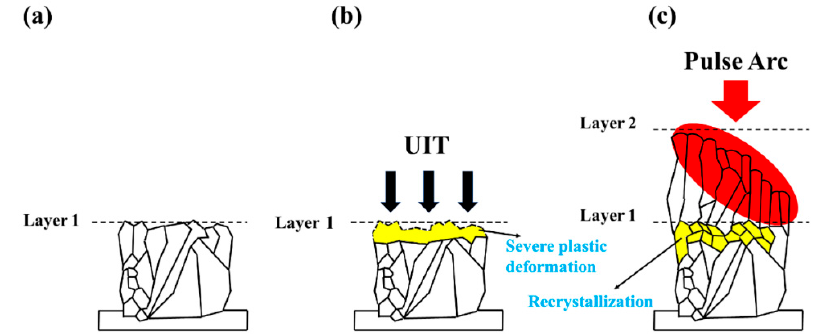
Figure 6. Schematic view of the grain growth of the UIT assisted WAAM process: ( a ) the deposition process for layer 1; ( b ) the UIT effect after deposition; ( c ) the remelting and recrystallization when the pulse arc is applied to layer 2.